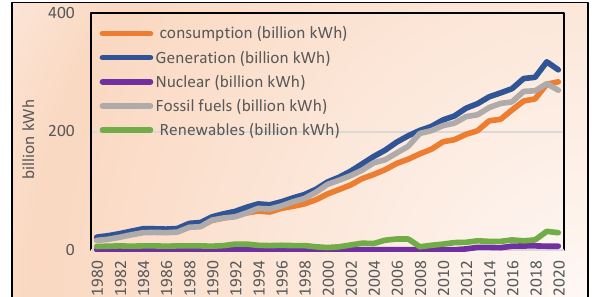
Figure 1 . Energy generation and consumption in Iran.